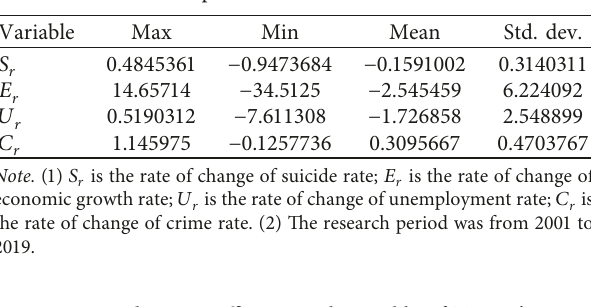
Table 4: Correlation coefficient analysis table of Taiwan’s entire economic growth rate and other independent